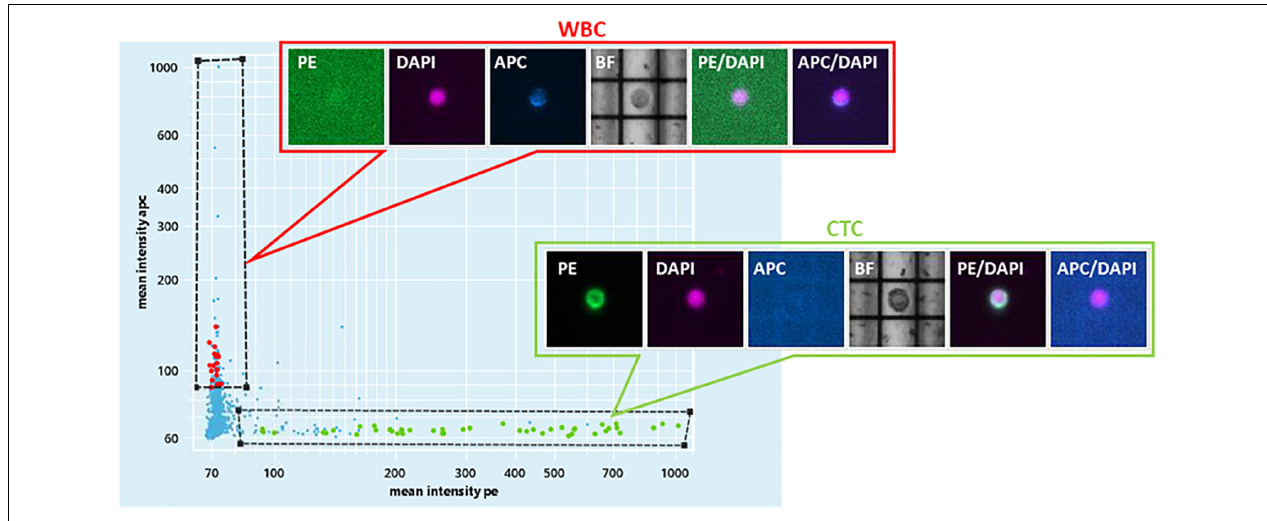
FIGURE 1 | DEPArray NxT analysis. Scatter plot of the enriched blood sample of patient#95. On the X -axis, the mean intensity fluorescence of PE channel is reported, corresponding to the intensity of CK IF staining. On the Y -axis, the mean intensity of CD45-APC is